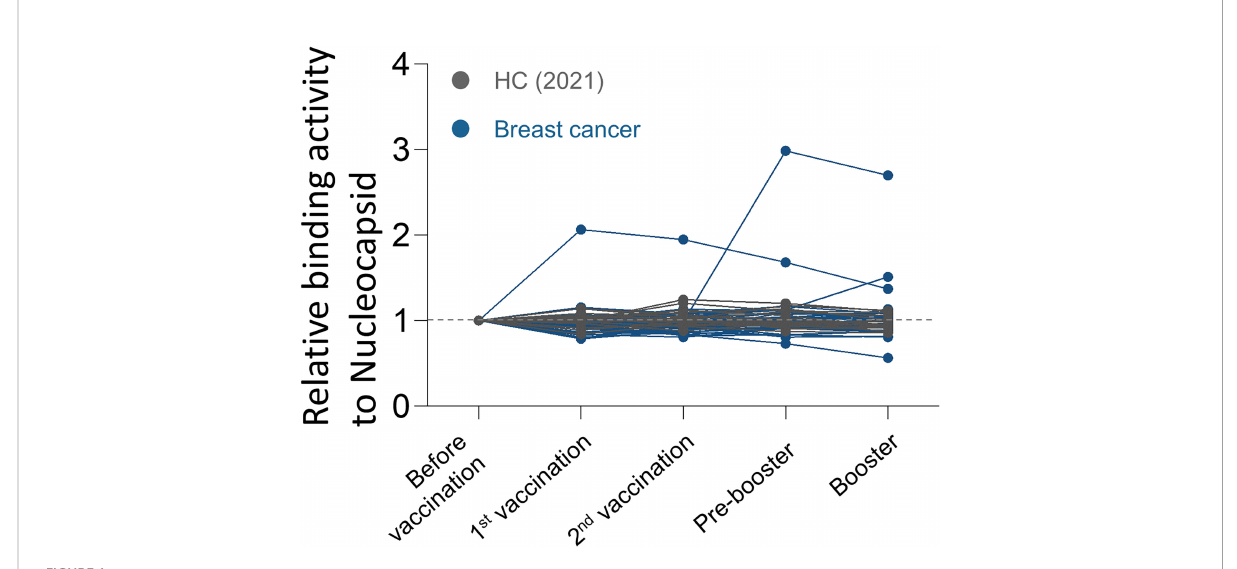
FIGURE 1 Antibody responses to SARS-CoV-2 nucleocapsid protein over time in breast cancer patients. Binding activities of IgG to SARS-CoV-2 nucleocapsid protein were determined using anti-IgG